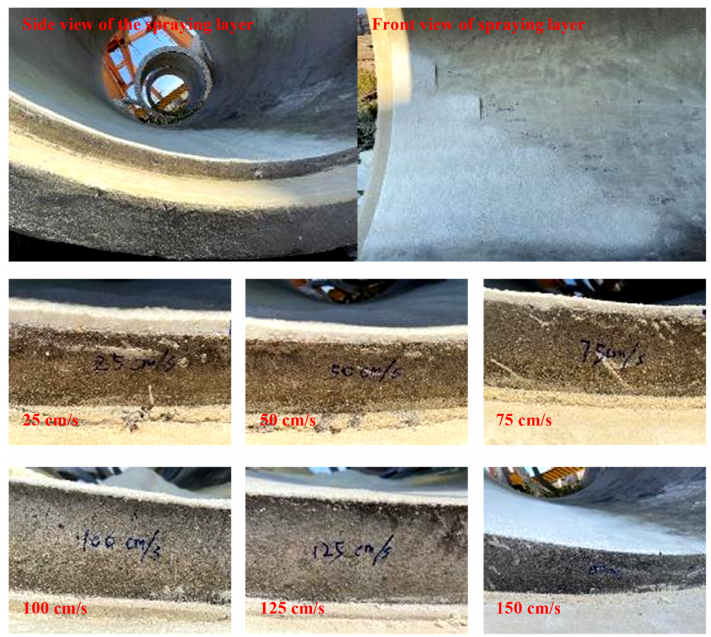
Figure 9. Spraying layer thickness at different v gun